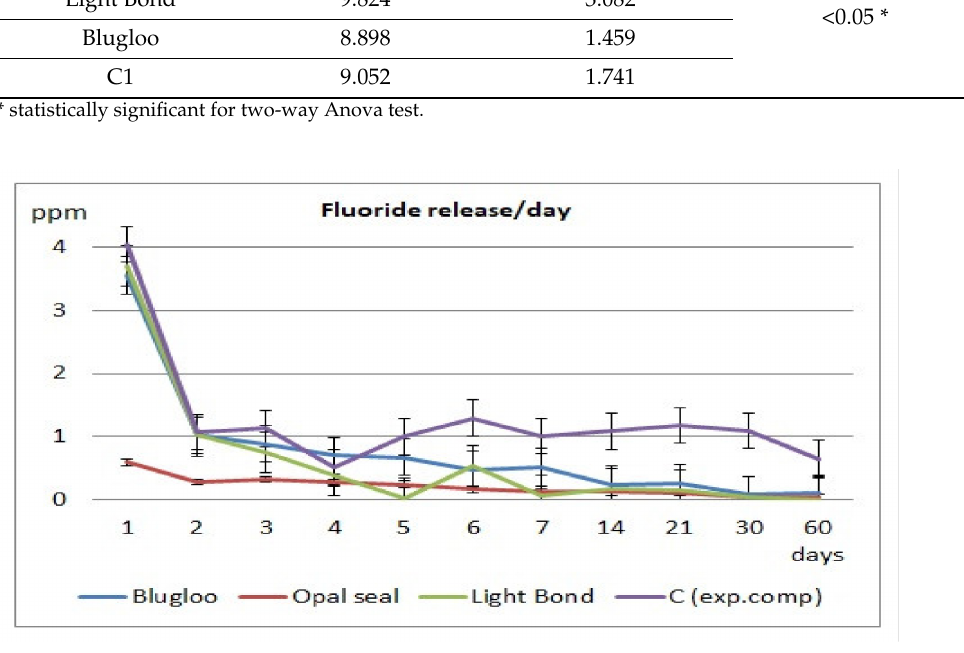
Figure 2. Daily fluoride release for the tested materials.